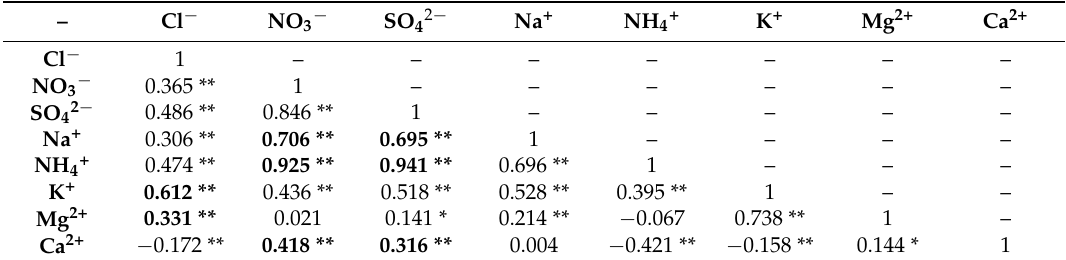
Table 6. Pearson correlation of the water-soluble ions in PM 2.5 in the